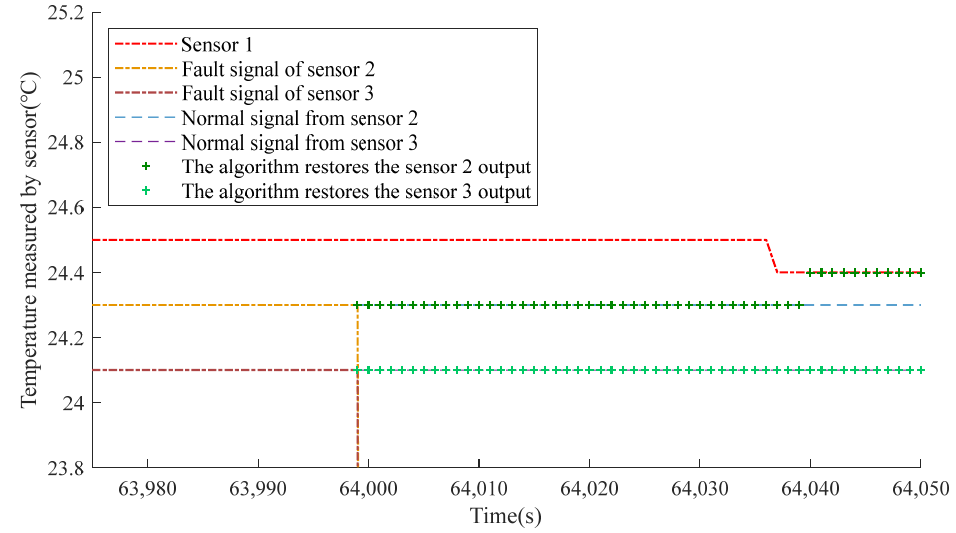
Figure 13. The data recovery for the bias failure of multiple sensors.